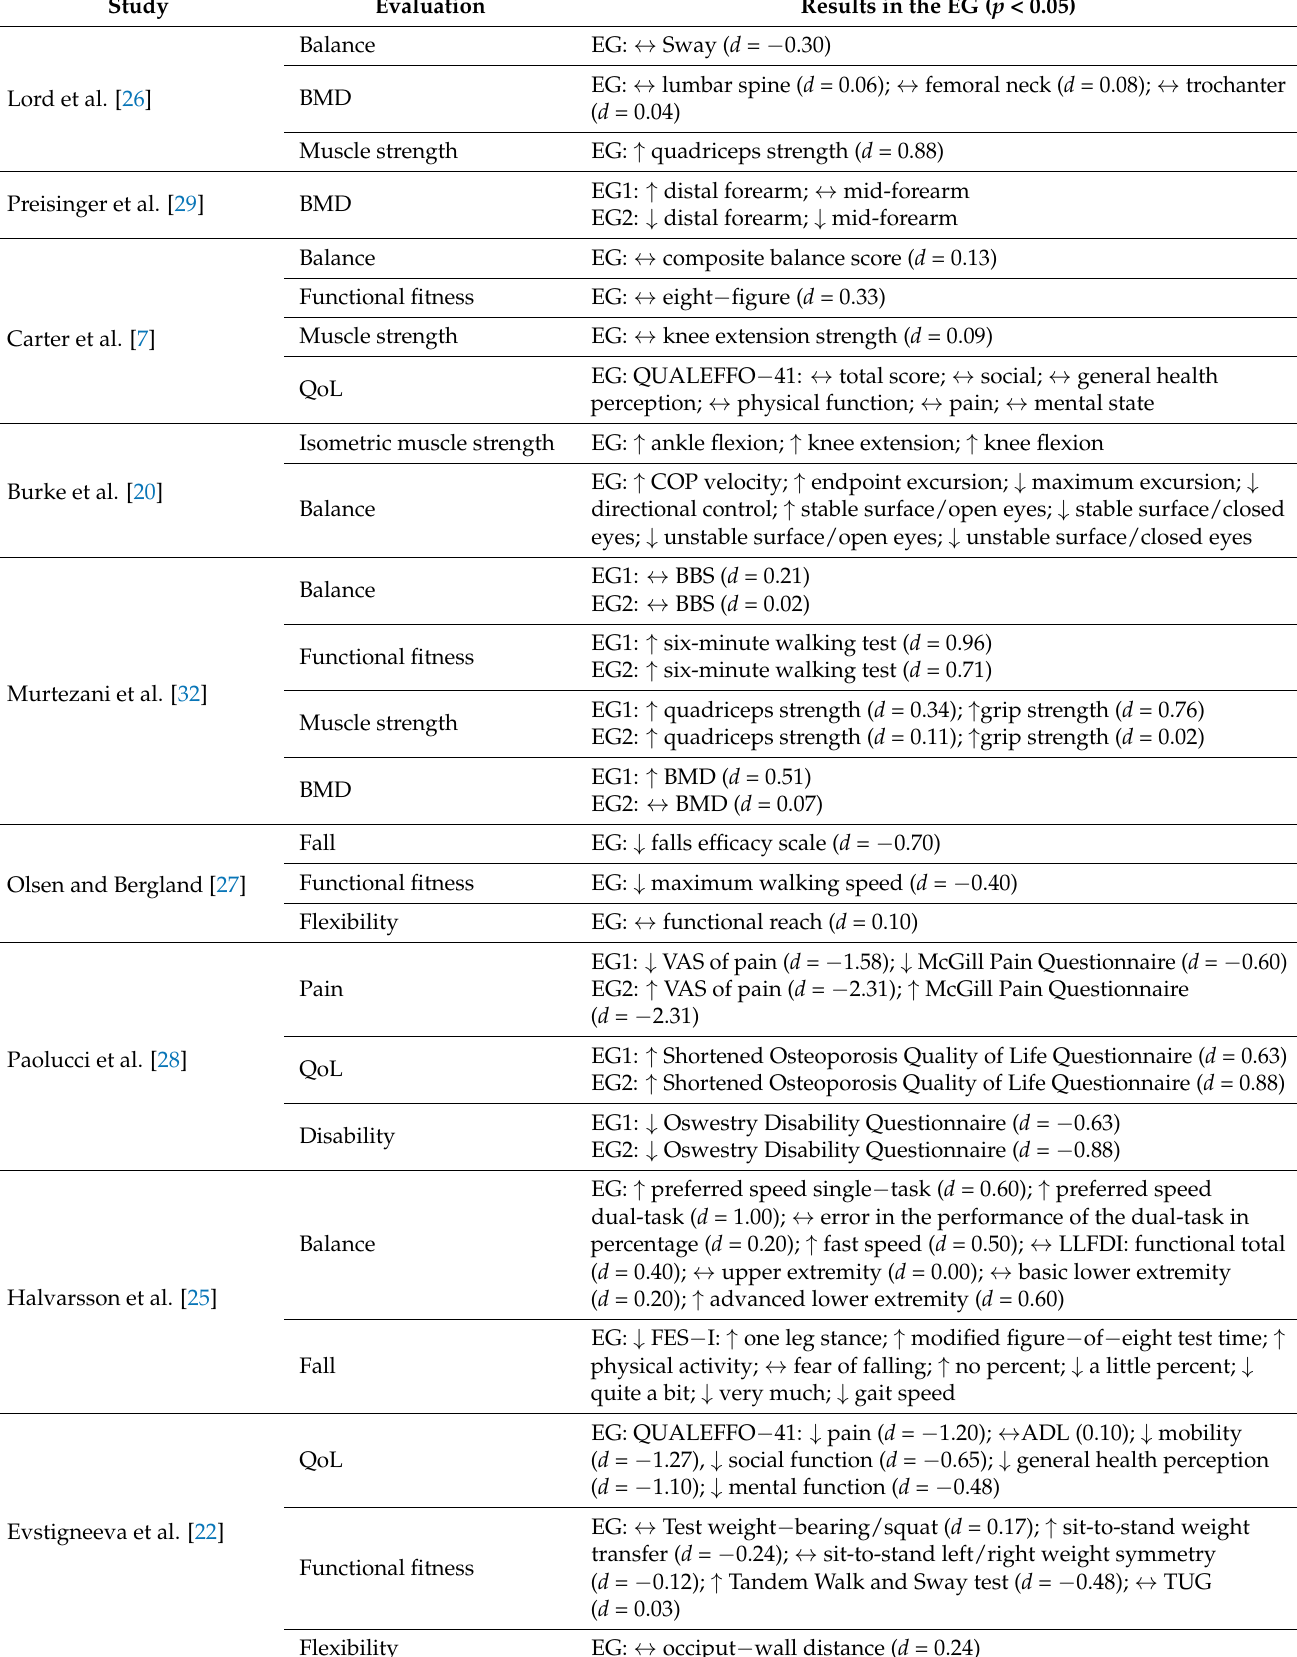
Table 5. Data from the variables analyzed and the results of the included